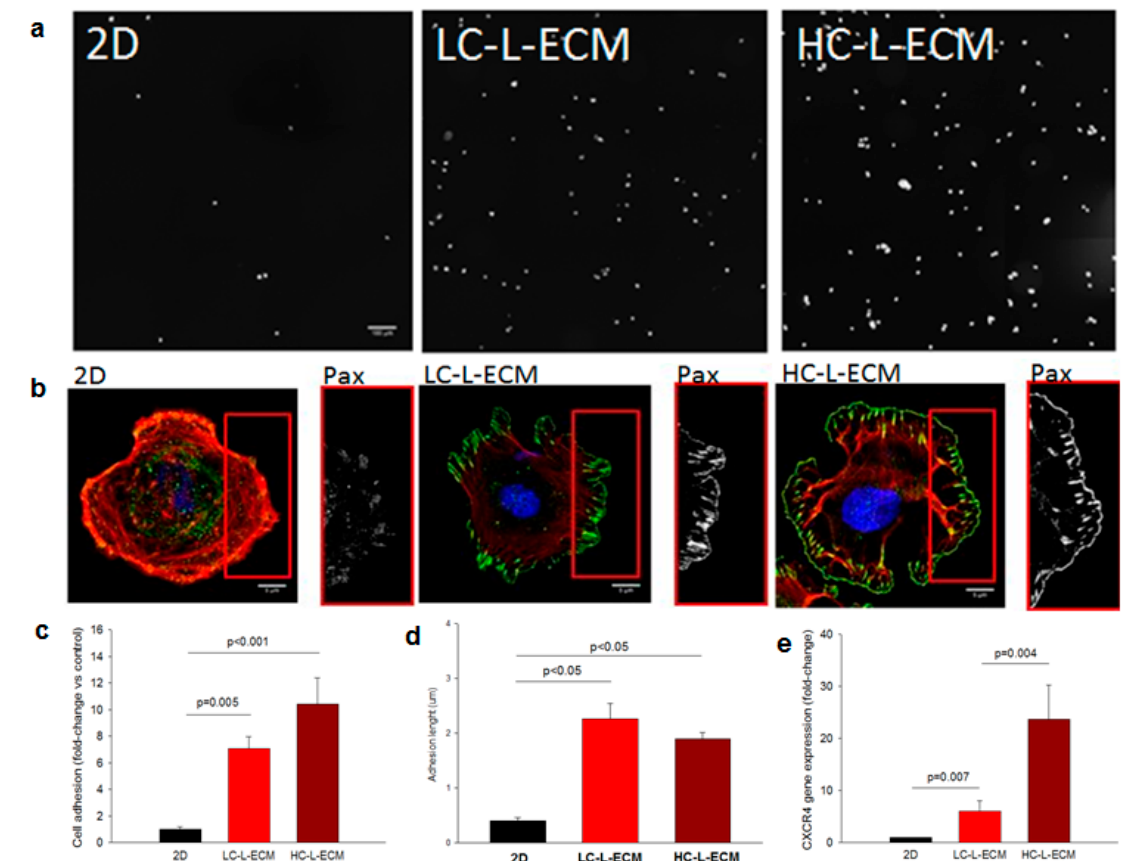
Figure 3. L-MSCs harvested from the 3D-cultured hydrogels. ( a ) Cell adhesion quantification: representative images of cells harvested from the LC-L-ECM and HC-L-ECM structures compared to the 2D-cultured control cells used (2 h after seeding). Scale bar = 100 µm ( b ) Representative images of the focal adhesion quantification from the actin (red) and paxillin (green) staining, colocalization is shown in white indicating the focal adhesions. Scale bar = 5 µm ( c ) Quantification of the number of adhered cells after 2 h seeding in plastic comparing the L-MSCs cells harvested from the hydrogels after 7 days of culture and the cells cultured in conventional 2D plastic substrate. Mean ± standard error (SE), n = 5 ( d ) Quantification of the focal adhesion length of the immunohistochemistry images of the actin and paxillin staining for the harvested and control cells after 2 h of reseeding them in plastic. Mean ± SE, n = 20 ( e ) qRT-PCR quantification of the expression of CXCR4 in the harvested L-MSC cells from the LC-L-ECM and HC-L-ECM structures after 7 days of 3D culture respect to the cells cultured in conventional 2D plastic substrate. Mean ± SE, n = 5.